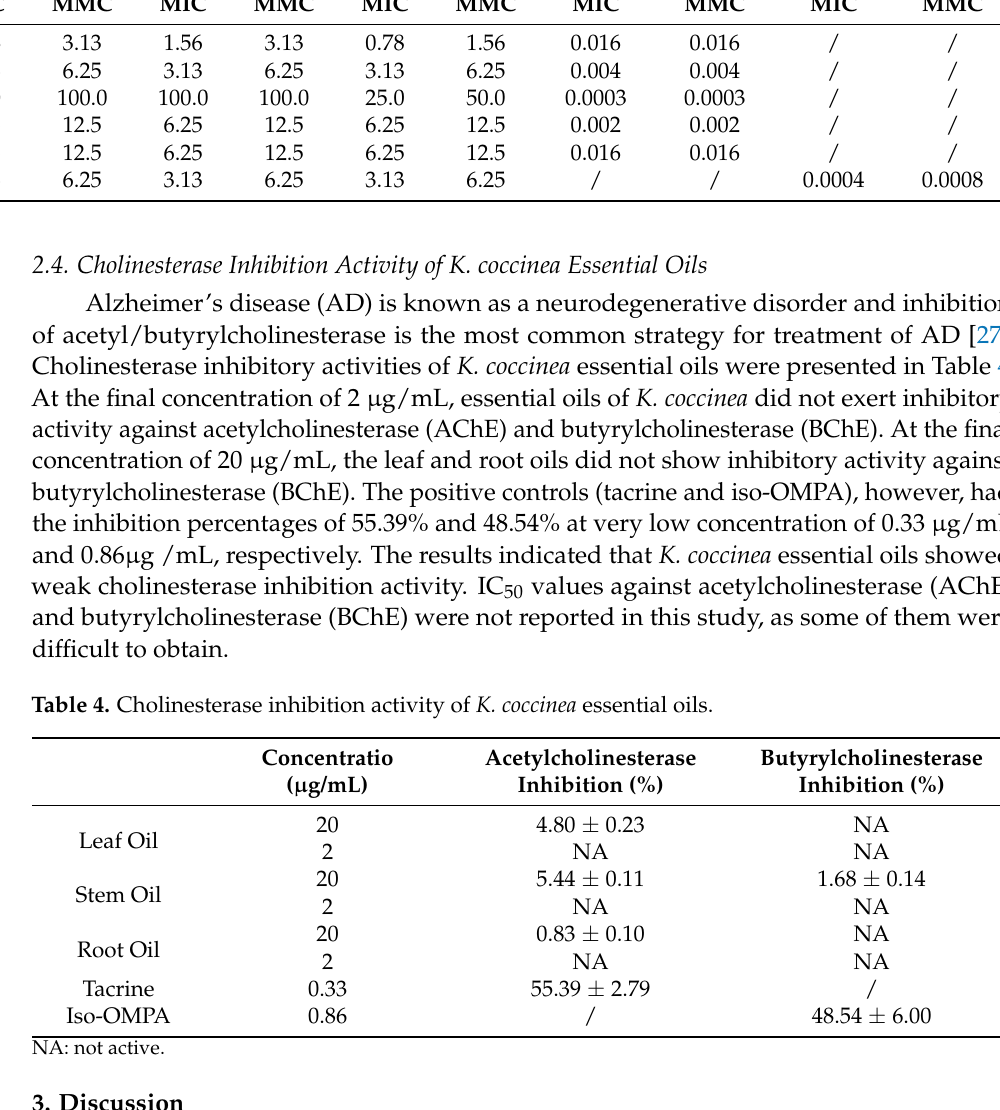
Table 3. Antimicrobial activity of essential oils of K. coccinea , given as MIC (mg/mL) and MMC (mg/mL). Leaf Oil Stem Oil Root Oil Gentamycin Sulfate Amphotericin B Species MIC MMC MIC MMC